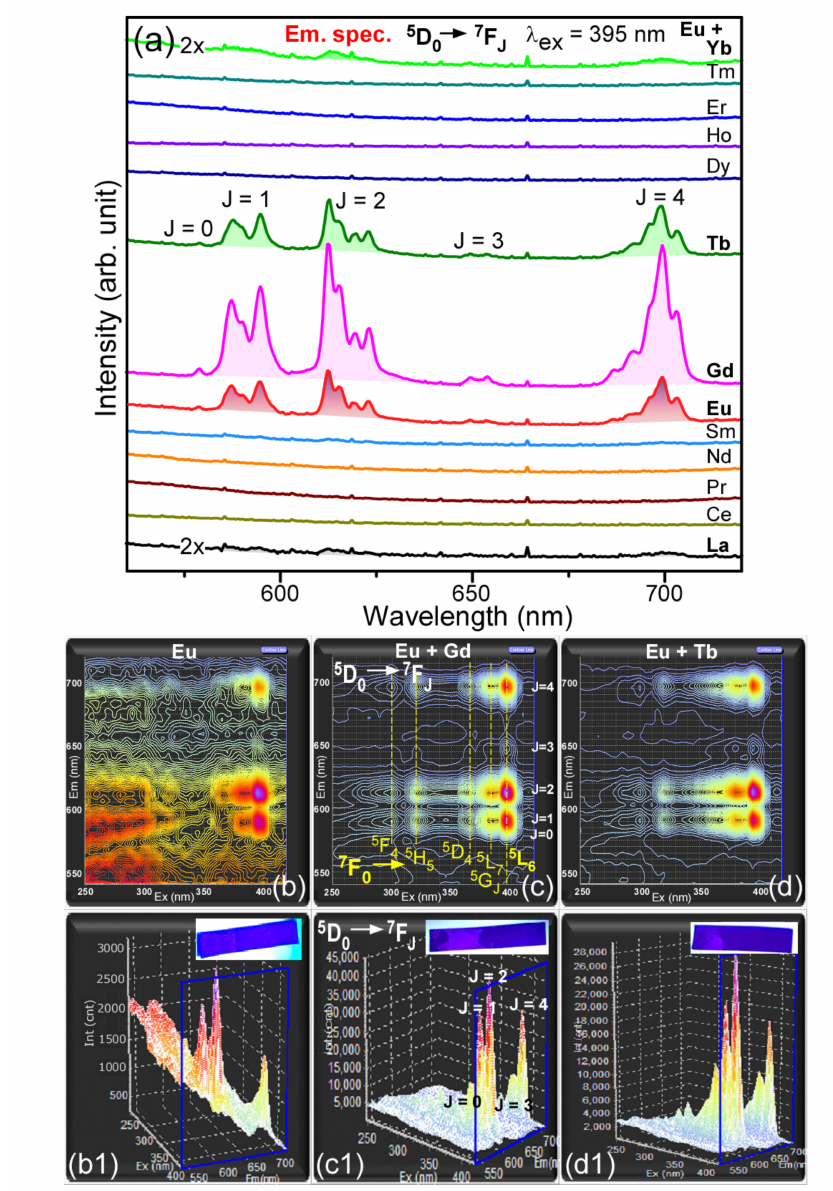
Figure 7. Emission spectra ( a ) of electrodeposited mixed Eu + Ln on TiNS-SiTpy electrodes and the selected 2D/3D-photoluminescence mapping profiles for electrodeposited Eu ( b and b1 ), Eu + Gd ( c and c1 ), and Eu + Tb ( d and d1 ). Inset photos show the corresponding samples under UV light. Photoluminescence decay kinetics were evaluated for the selected electrodeposited Eu, Eu + Gd and Eu + Tb samples, and the PL decay curves are displayed in Figure